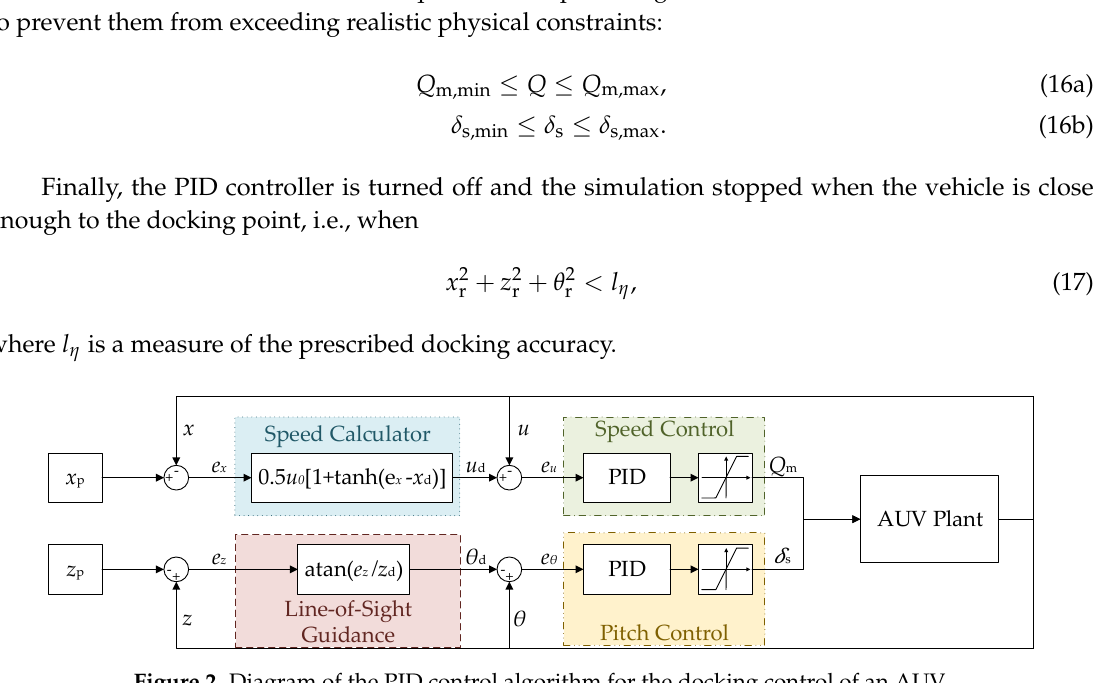
Figure 2. Diagram of the PID control algorithm for the docking control of an